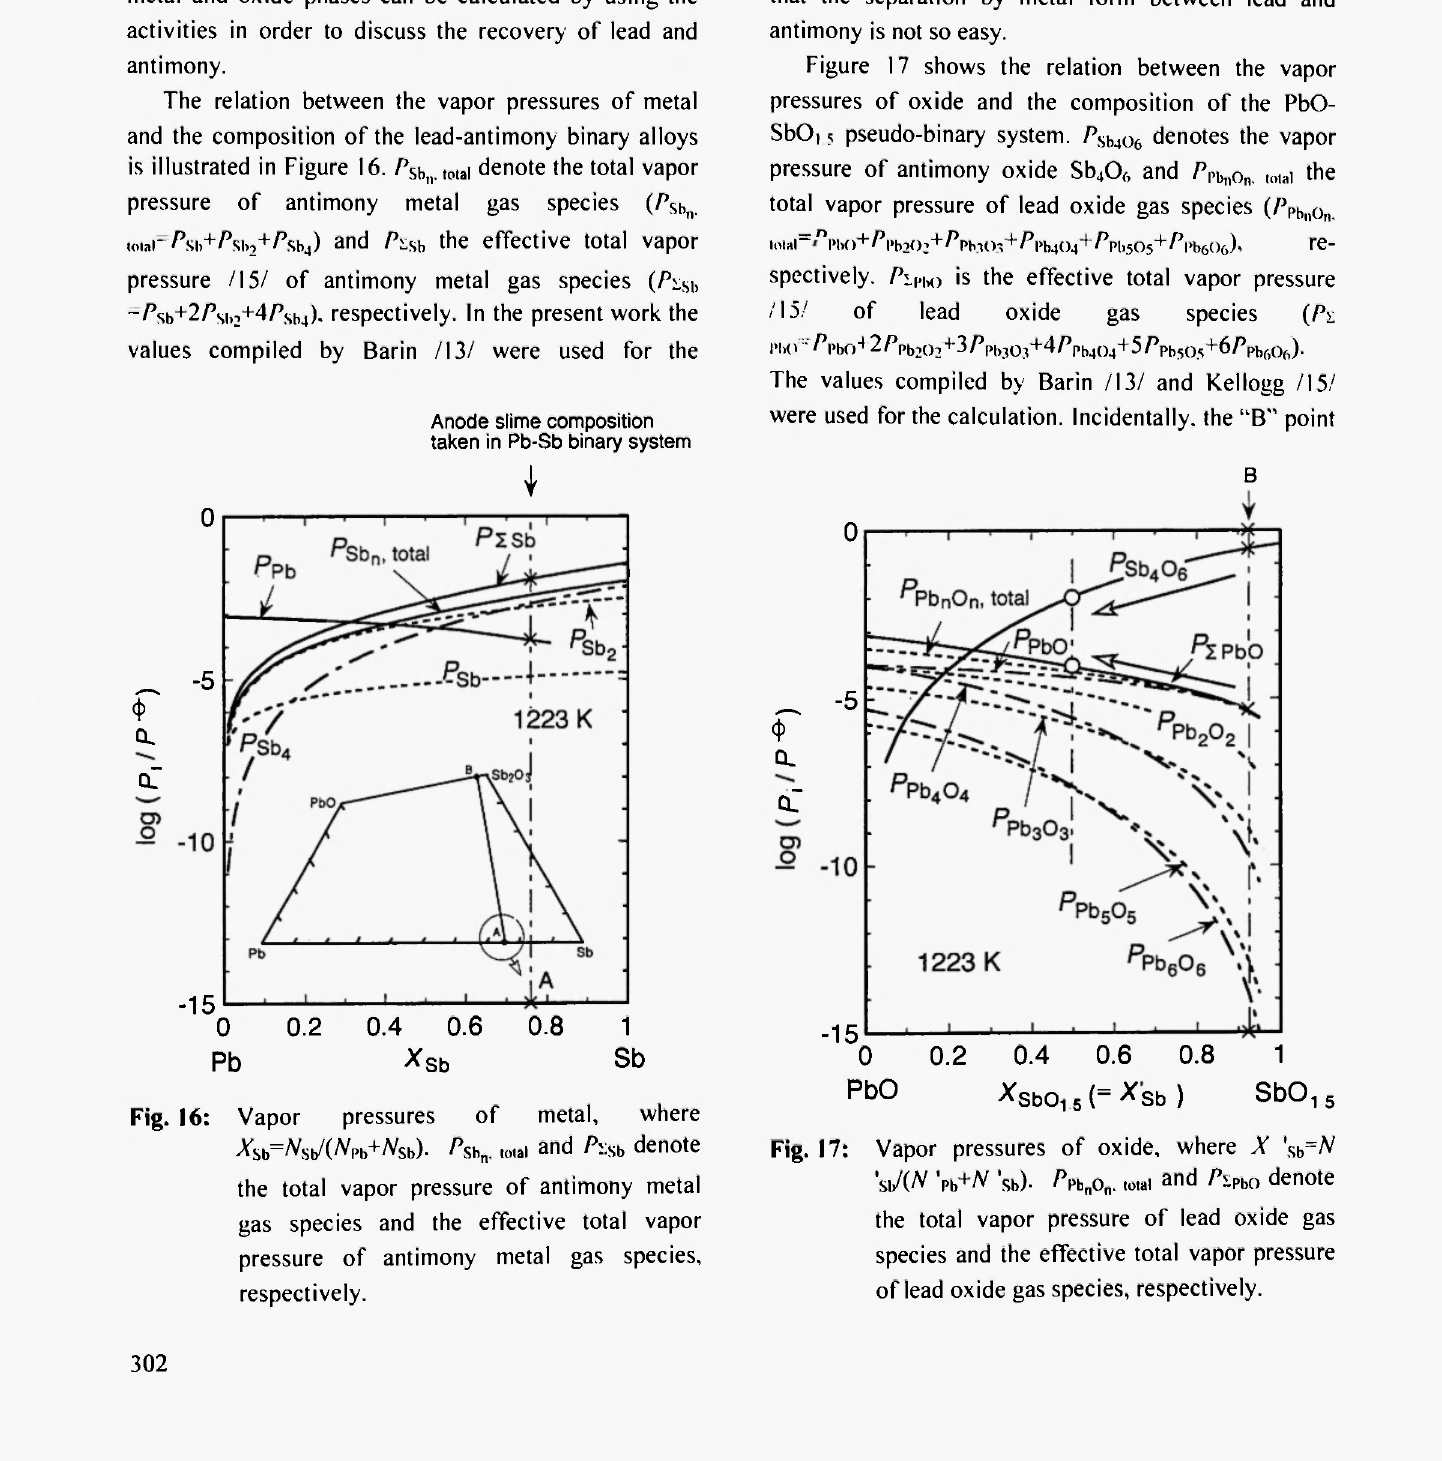
Fig. 17: Vapor pressures of oxide, where X \ b =N V(/V Vb+W 'sb)· ΡPh n o n . total and /'i Pb0 denote the total vapor pressure of lead oxide gas species and the effective total vapor pressure of lead oxide gas species,